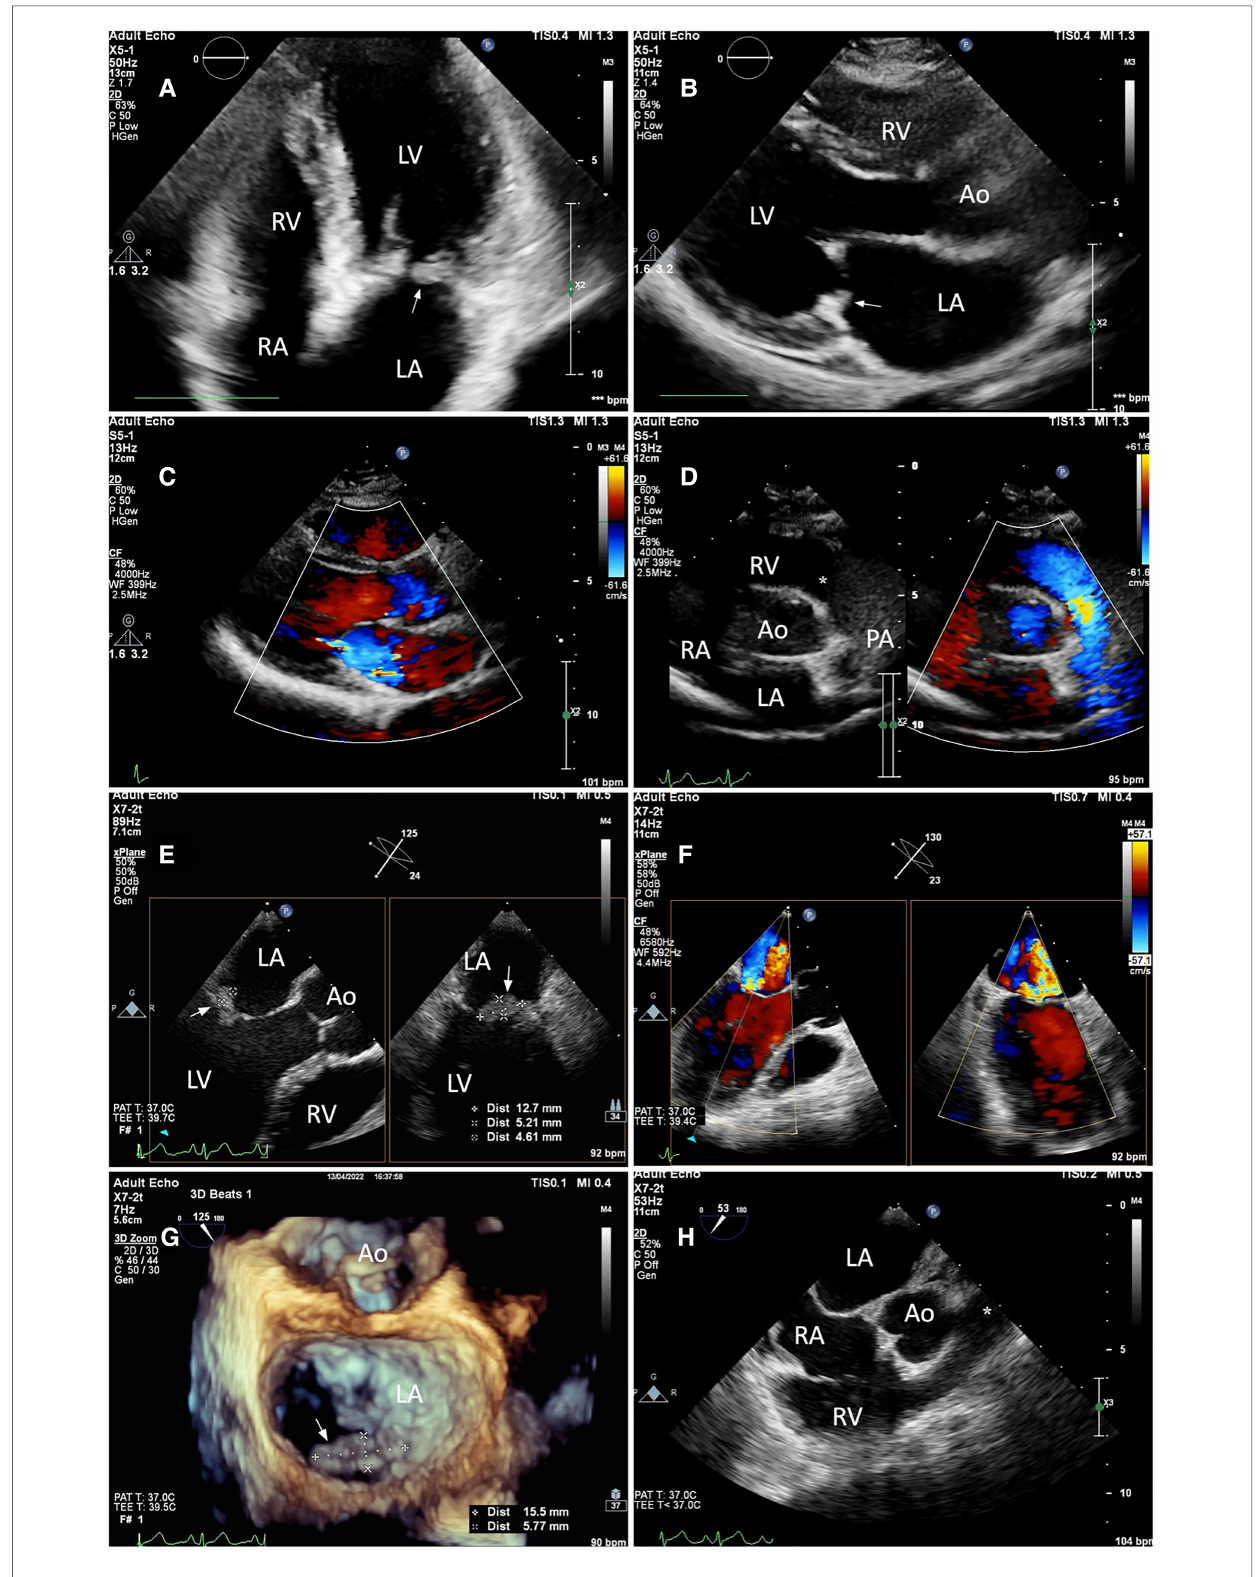
FIGURE 1 Still-frame images of the mitral and pulmonary valves on TTE ( A – D ) and TEE ( E – H ). ( A,B ) TTE apical four-chamber and parasternal long axis views revealed a well-circumscribed, sessile mass with heterogeneous echotexture which was fi rmly attached to the atrial side of the posterior lea fl et of the mitral valve (white arrow). The mitral valve lea fl ets were thickened. ( E ) The maximum diameter of the mass was measured using 2D Xplane imaging at the mid- esophageal level. ( G ) From the left atrial perspective (en-face view), the vegetation was seen attached to the atrial side of the P2 and P3 portions of the posterior lea fl et (white arrow) with 3-dimensional zoom-mode. ( C,F ) mild-to-moderate central mitral regurgitation was seen on both TTE and TEE with color Doppler. ( D,H ) The pulmonary valve as visualized on the parasternal short-axis and mid-esophageal right ventricle in fl ow-out fl ow view was unremarkable (asterisk). Annotations: LA, left atrium; LV, left ventricle; RA, right atrium; RV, right ventricle; Ao, Aorta; PA, pulmonary